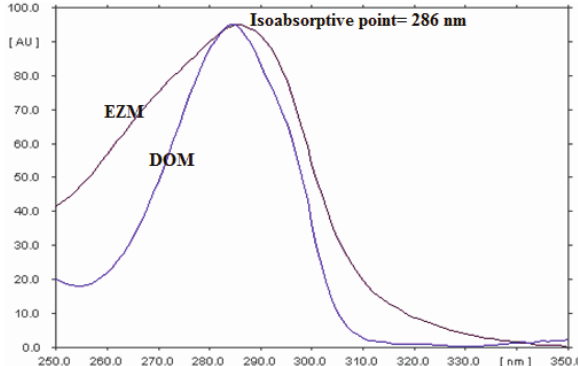
Figure 2: Absorption spectra of EZM and DOM showing their isoabsorptive point.